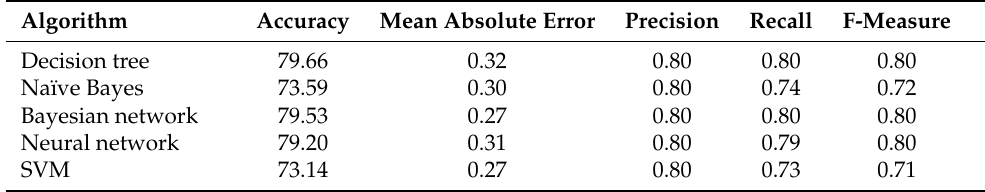
Table 13. LOC and readability metrics results for summation division approach using cross- validation.